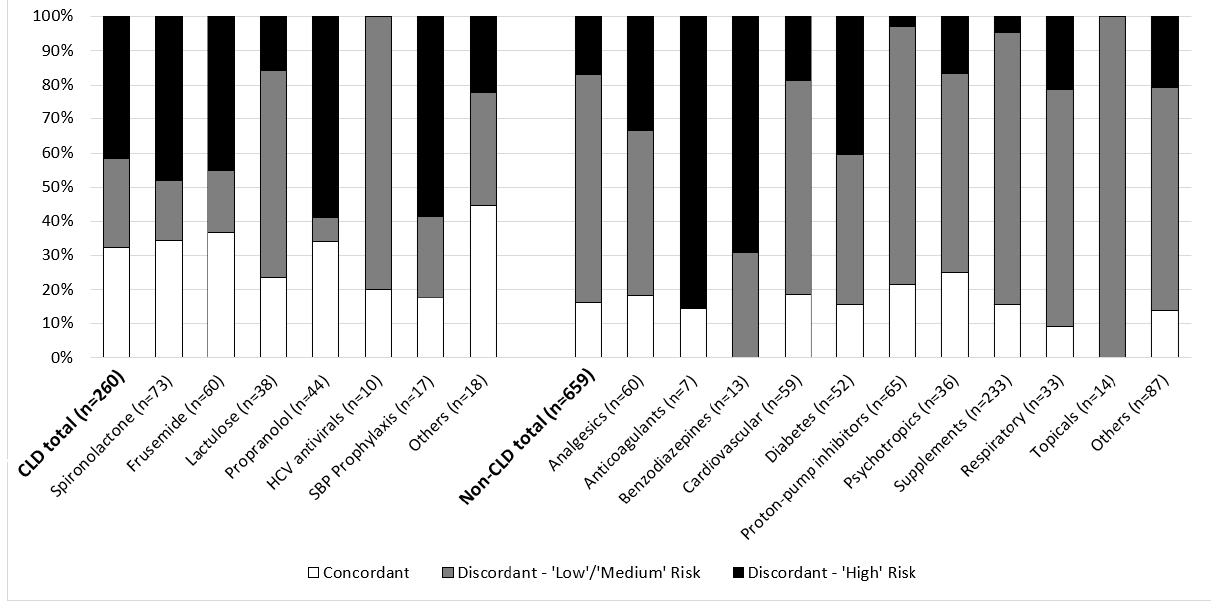
Figure 2. Proportion of discordant CLD and non-CLD medications following comparison of patient-reported and clinician-documented medications at baseline. A total of 919 distinct medications are represented (of which 800 were disclosed by patients and 620 were documented in the EMR).